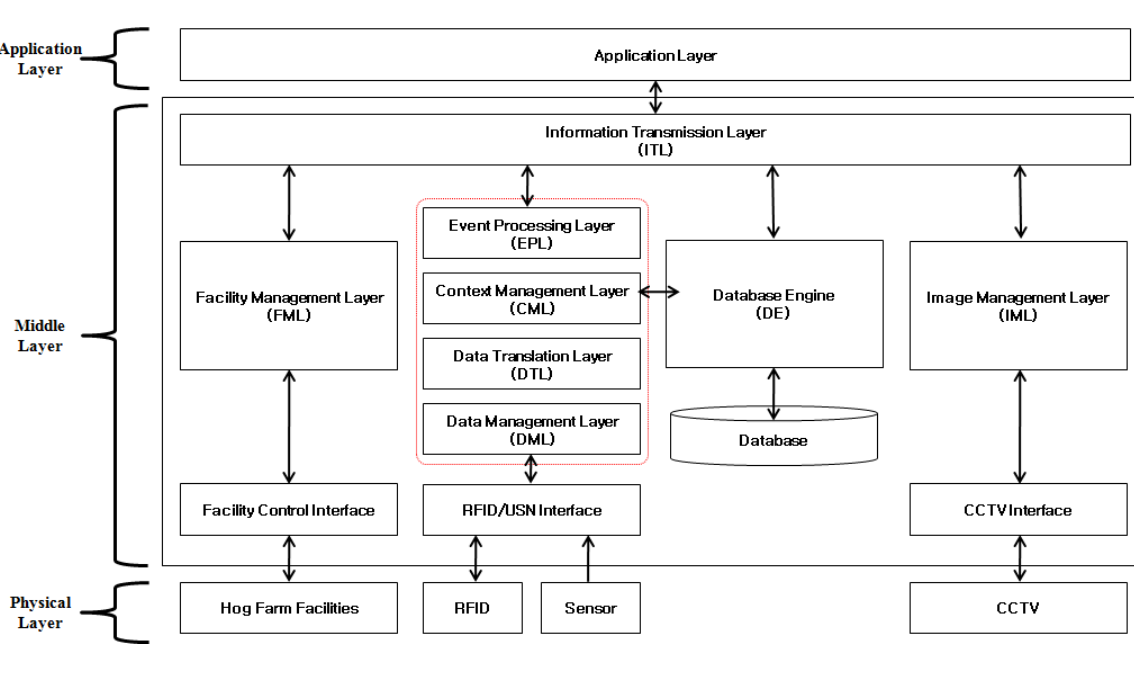
Figure 2. Ubiquitous Hog Farm System